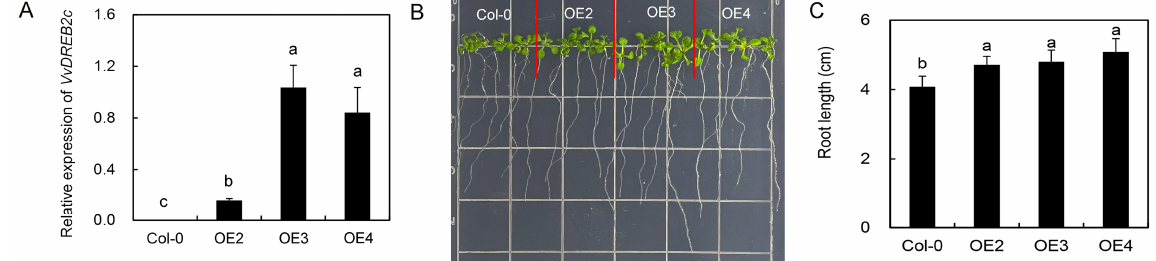
Figure 3. Effect of heterologous VvDREB2c expression and mannitol supplementation on VvDREB2c expression and phenotypes in Arabidopsis. ( A ) VvDREB2c expression in Col-0 and transgenic lines. ( B ) Leaves of plants grown on normal medium. ( C ) Root length of plants grown on normal medium. Different letters over bars indicate significant differences ( p < 0.05).